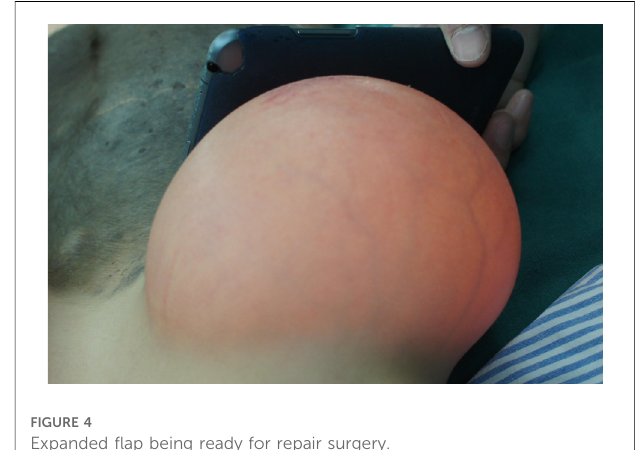
FIGURE 4 Expanded fl ap being ready for repair